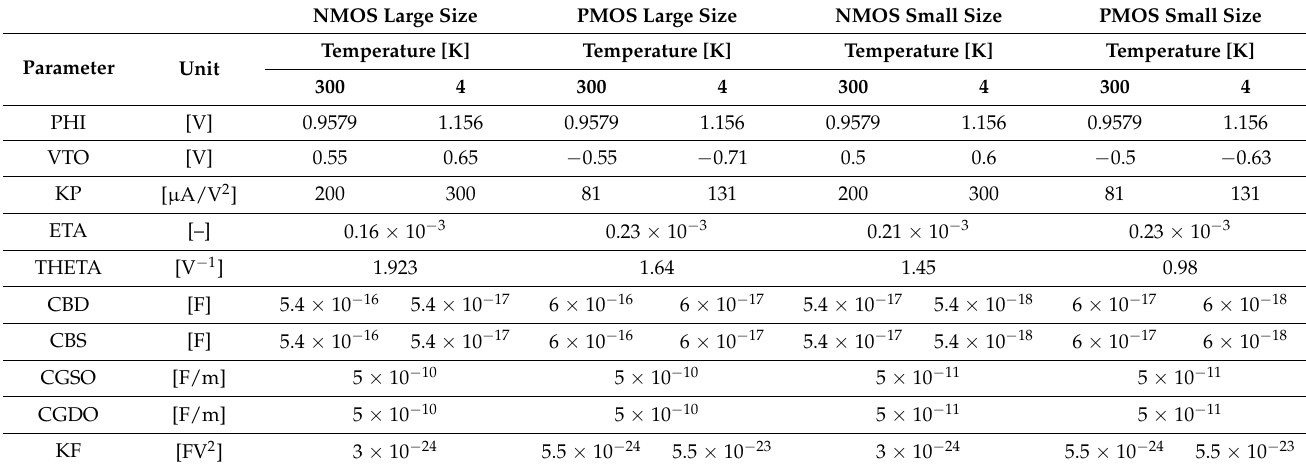
Table 1. Parameters of the MOS3 models for NMOS and PMOS transistors at 4 K and 300 K. NMOS Large Size PMOS Large Size NMOS Small Size PMOS Small